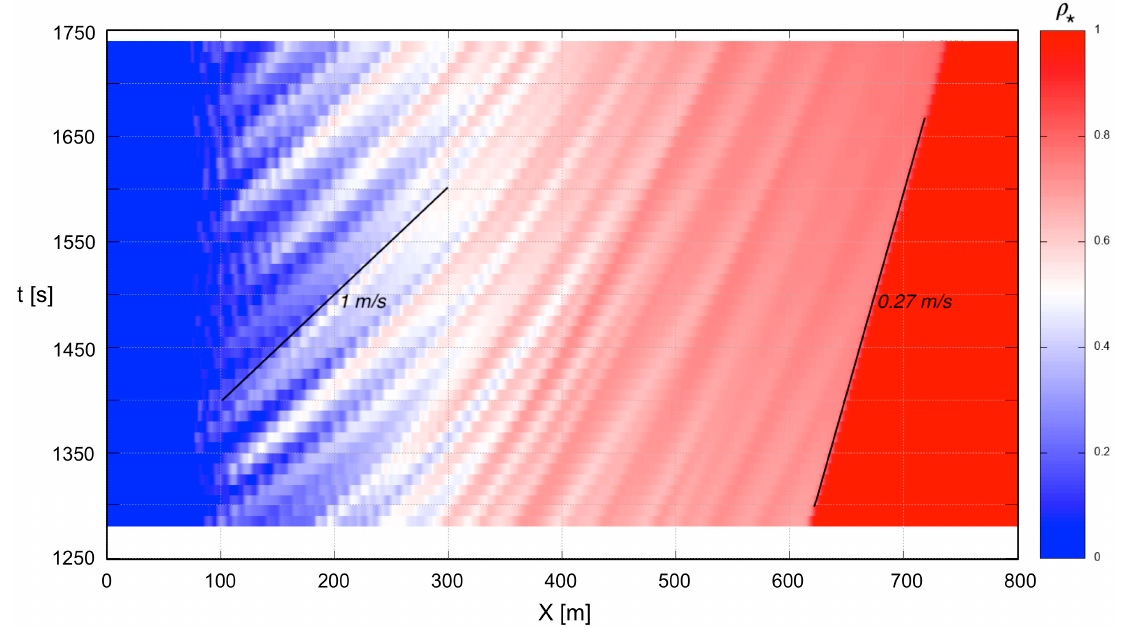
Figure 5. A Hovmöller (x-t) diagram showing the evolving centerline surface density. Rings, indicated by blue-white streaks, move at 1 m s − 1 near their source region, but slow with increasing offshore distance. The plume front propagates into ambient water (red area) at a steady radial speed of 0.27 m s − 1 . The time period shown matches that in Figure S1.